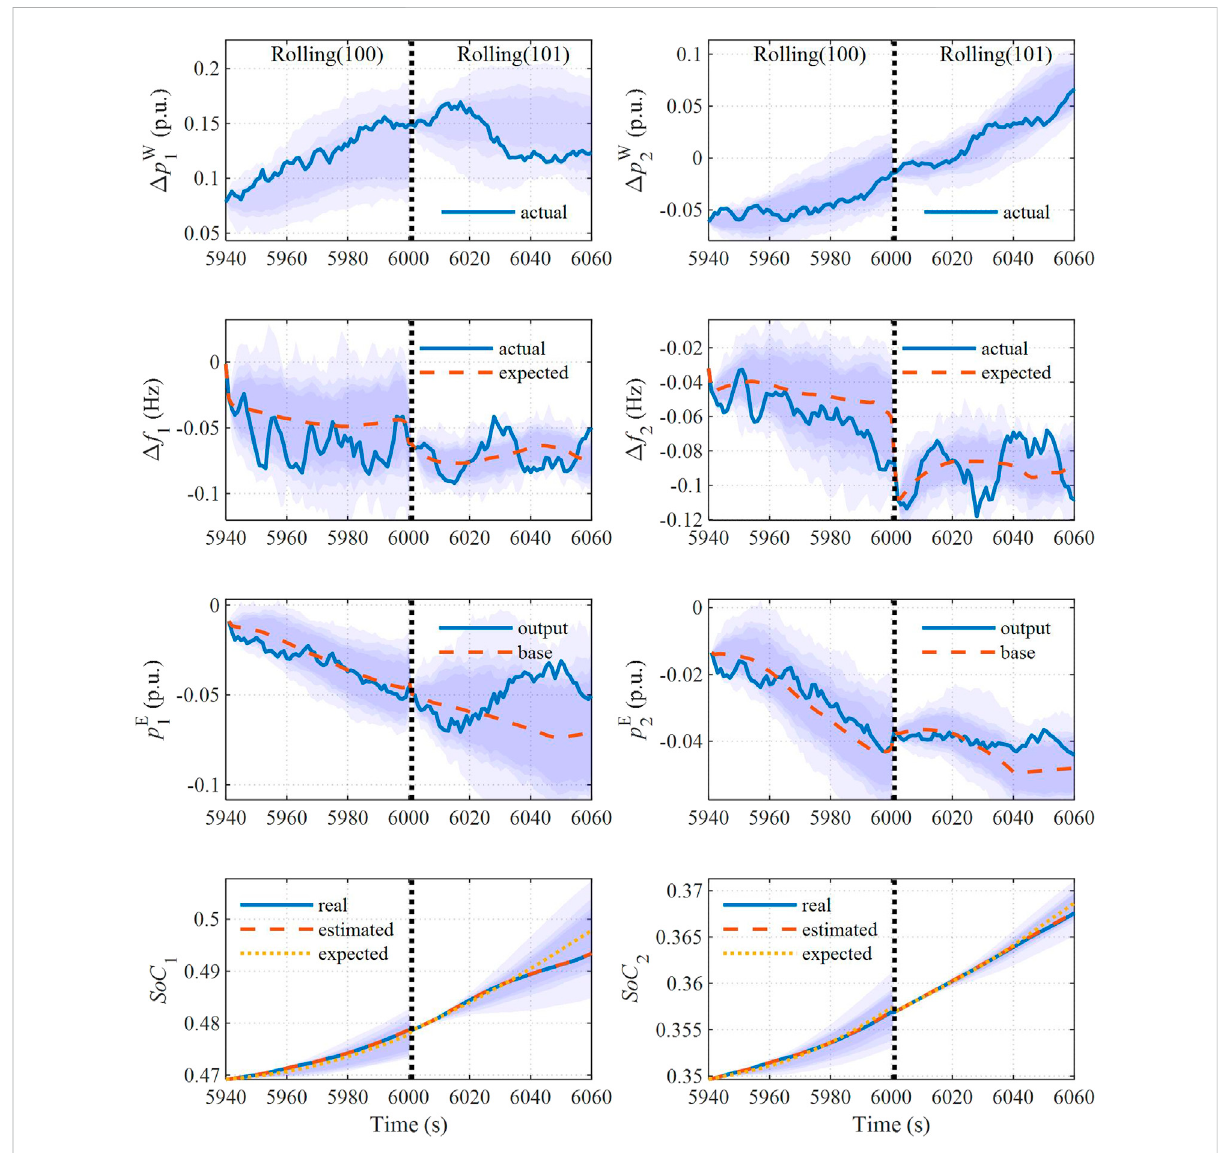
FIGURE 8 ActualresultsandMonteCarlosamplesof (A,B) windpowerdeviation, (C,D) frequencydeviation (E,F) poweroutputoftheESScluster,and (G,H) SoC level of the ESS